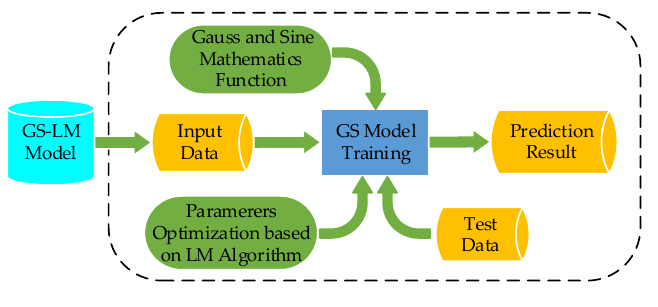
Figure 4. The structure of GS-LM Model.